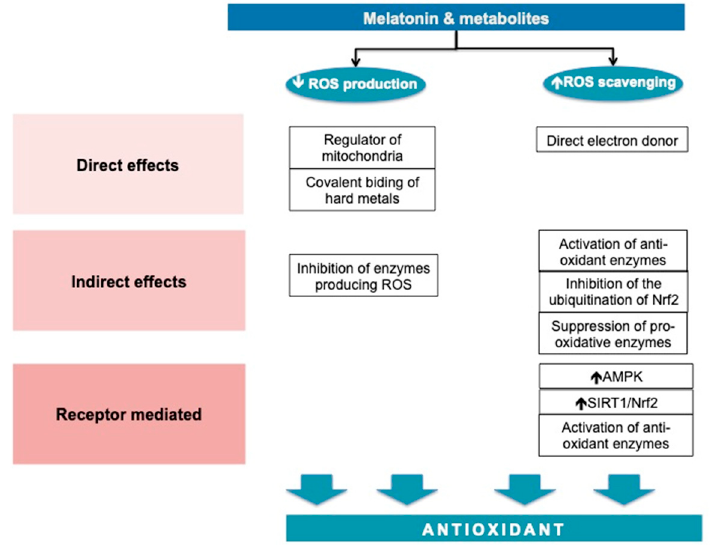
Figure 3. Melatonin—an antioxidant molecule.